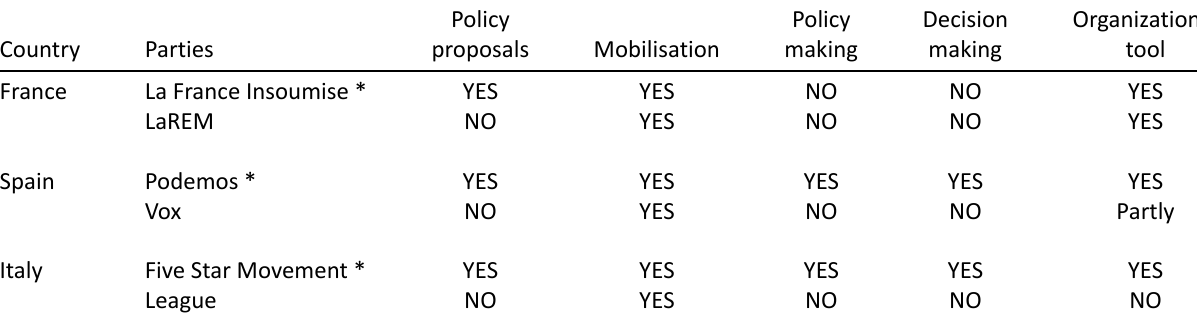
Table 2. Use of digital tools.